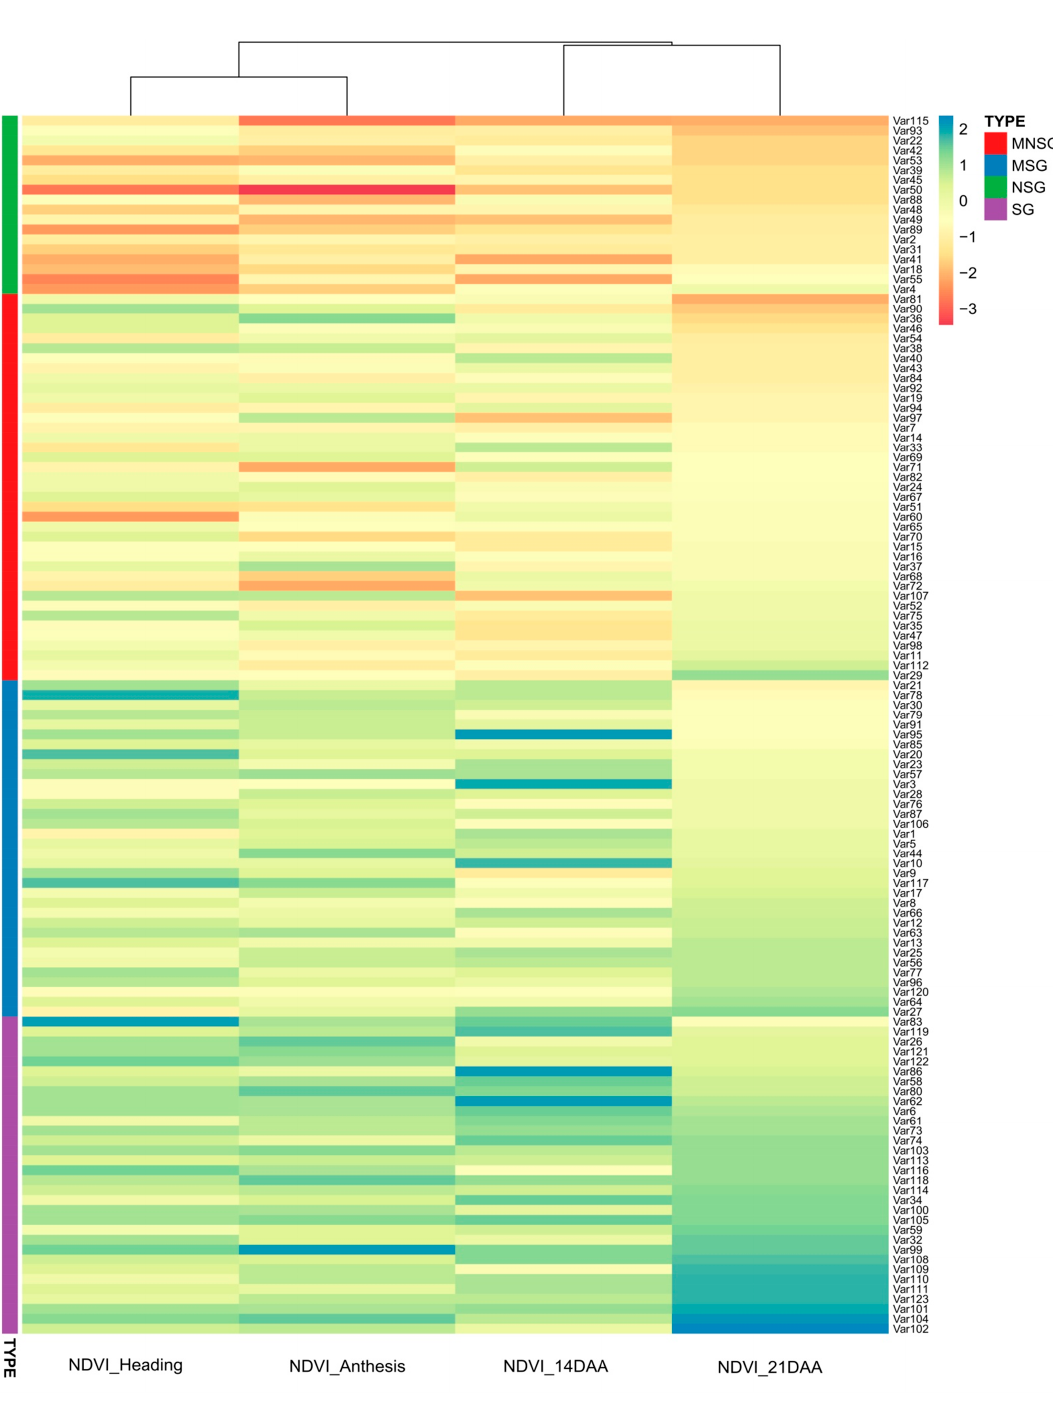
Figure 1. Heatmap depicting the normalized di ff erence vegetative index (NDVI) in the non-stay-green (NSG), moderately non-stay-green (MNSG), moderately stay-green (MSG), and stay-green (SG) genotypes at di ff erent developmental stages under control condition. The blue color represents the maximum value for the NDVI and the red color indicates the minimum value for the